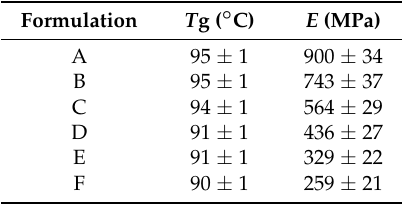
Table 5. T g and E values for A–F materials as determined by